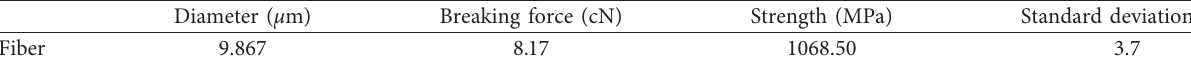
Table 2: Mean tensile strength of the investigated fibers.